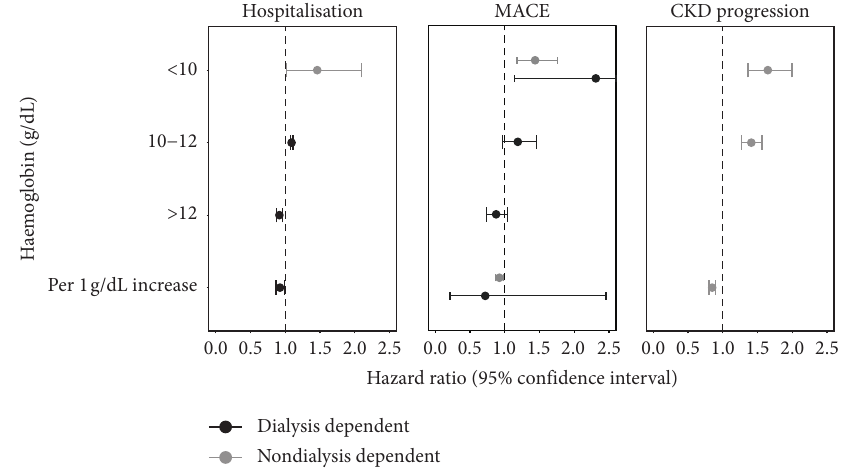
Figure 4: Associations between Hb level and hospitalisation, MACE, and CKD progression in CKD